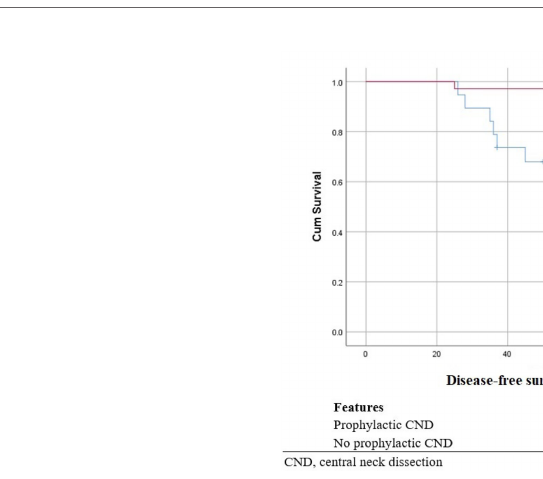
FIGURE 2 | Kaplan – Meier curves estimating disease-free survival according to surgical procedure.